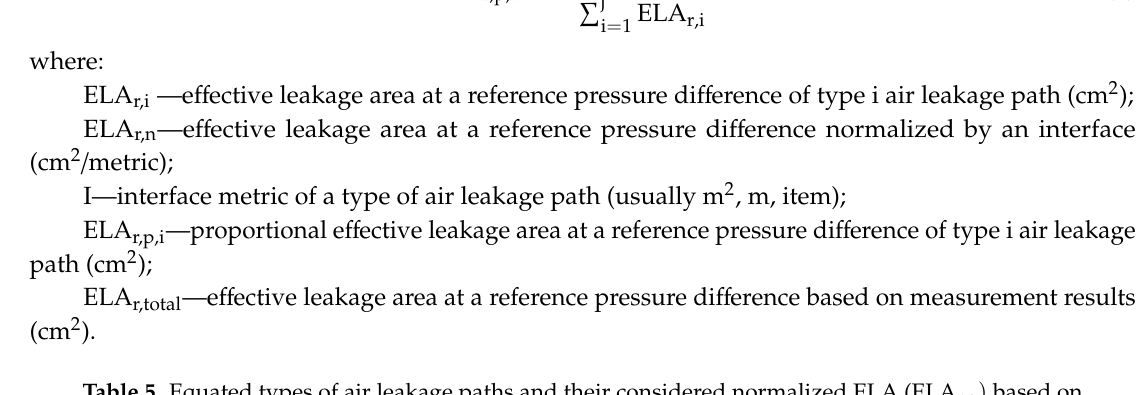
Table 5. Equated types of air leakage paths and their considered normalized ELA (ELA r,n ) based on best estimate values [55].